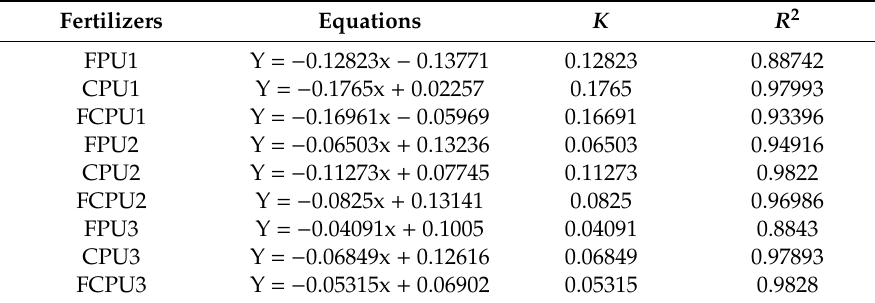
Figure 9. Release kinetics of FPUs, CPUs and FCPUs for ( A ) 4%, ( B ) 6% and ( C ) 8% in water at 25 °C. Table 6. Release kinetic parameters of FPUs, CPUs and FCPUs in